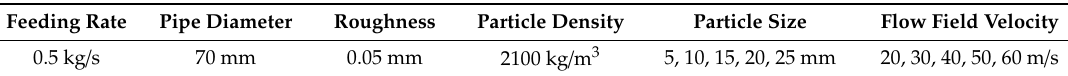
Table 1. Simulations parameters.